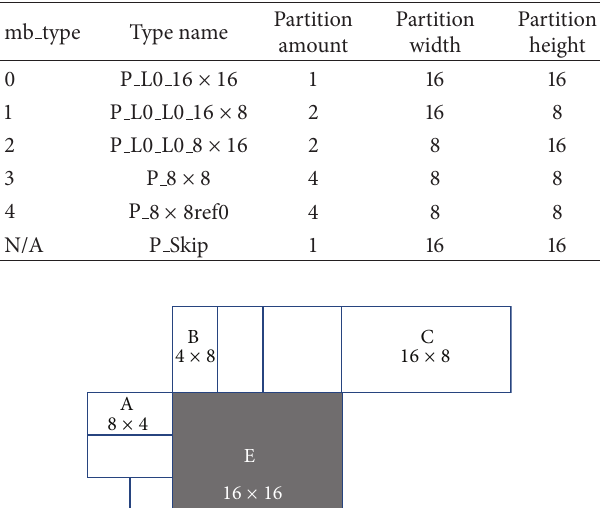
Table 2: mb type in P slice.